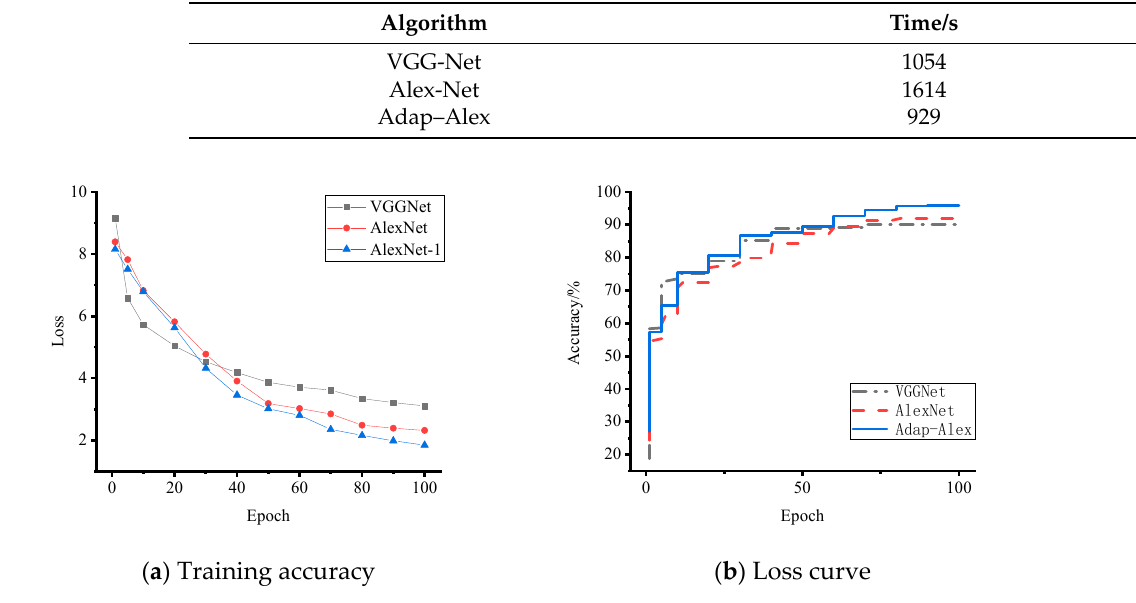
Figure 11. Training accuracy and loss curve.